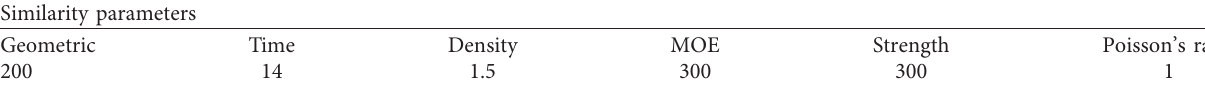
Figure 1: Damage to a roadway caused by a rock Table 1: Similarity parameters.